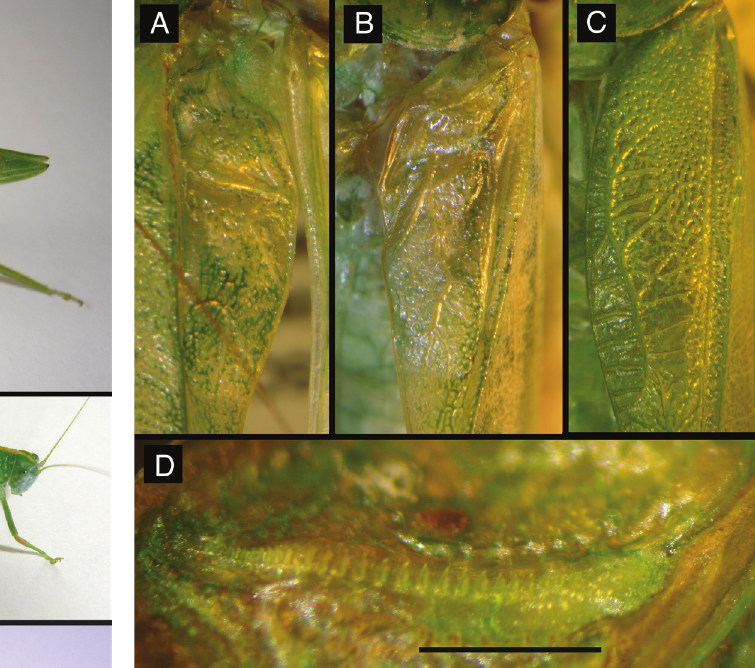
Fig. 3. A, B. Left and right, respectively, stridulatory areas in male and C. Female tegmina (scale 5 mm); D. Male stridulatory file (distal end to the left; scale 1